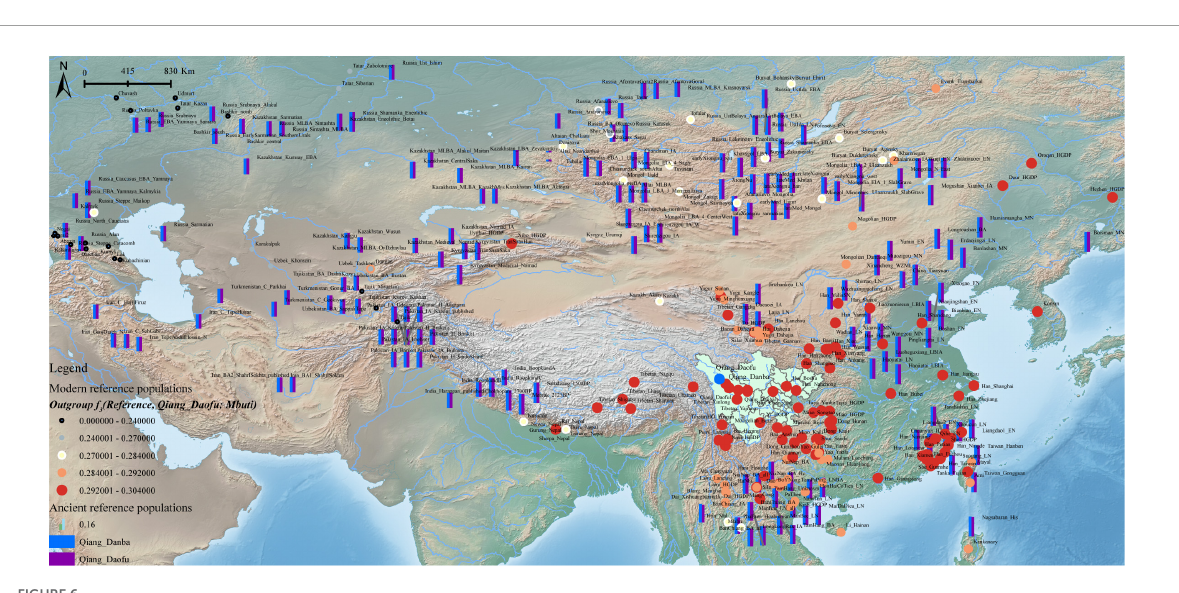
FIGURE6 Shared genetic drift between Danba and Daofu Qiang people and Eurasian reference populations. Bar showed the genetic affinity between the Qiang people and the ancient Eurasian populations. Circle size and color showed the genetic affinity between Daofu Qiang and modern reference